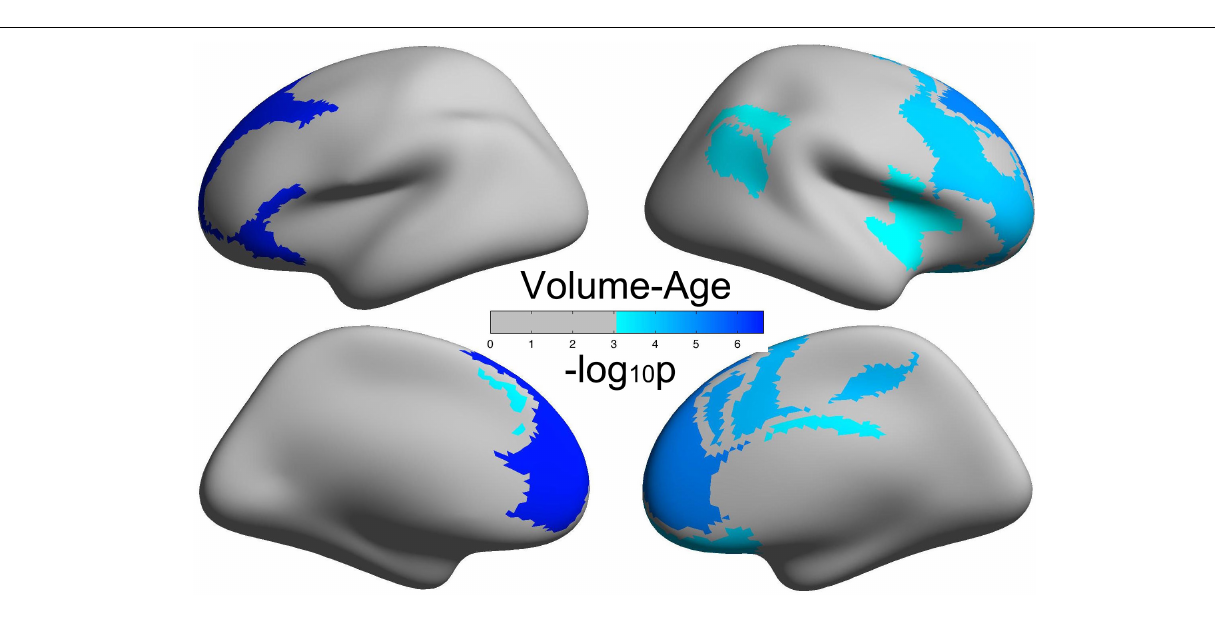
FIGURE 2 | Brain regions with a significantly decreased cortical volume (CV) of the human brain with age. TABLE 2 | Brain regions with significant negative correlations between cortical volume and age ( p < 0.05/51). Brain